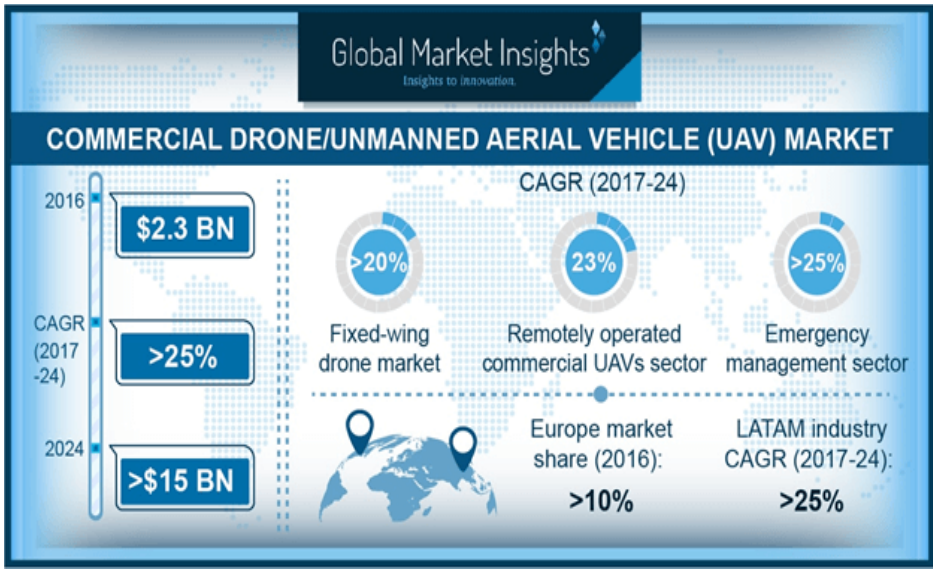
Figure 1. UAV market outlook [13].